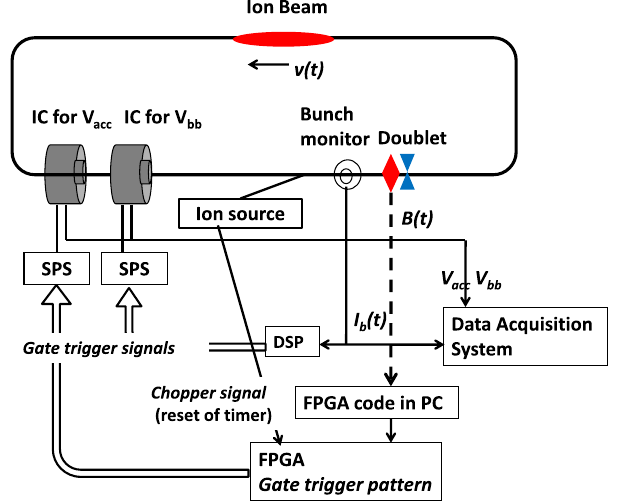
FIG. 11. Control block diagram of the induction acceleration system.